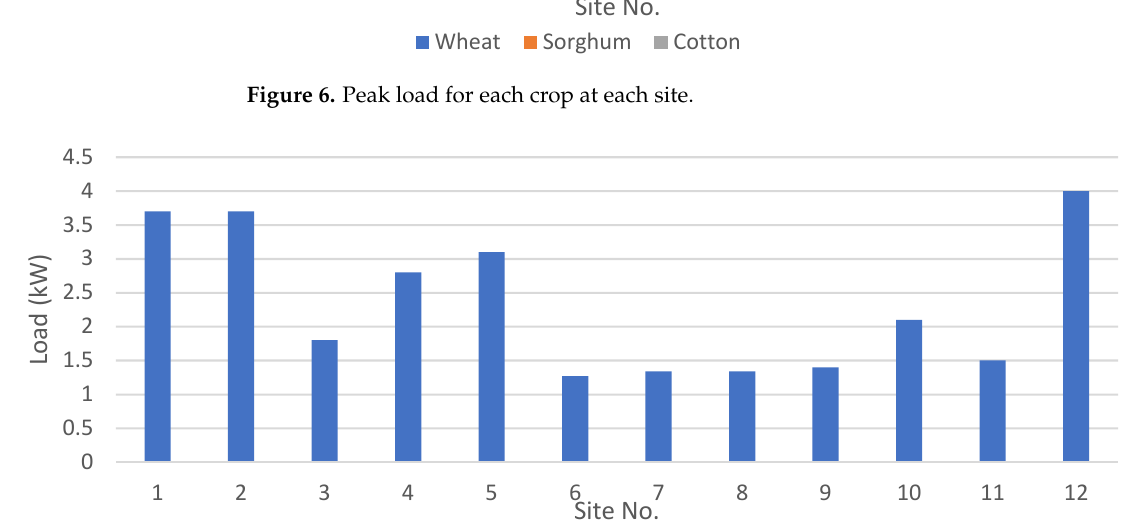
Figure 7. Cumulative peak load for all of the sites [12].